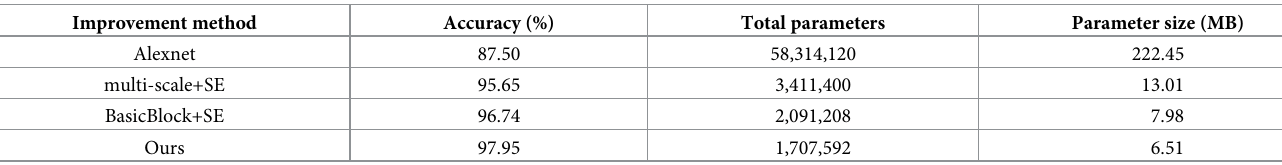
Table 1. Comparative results of module addition.